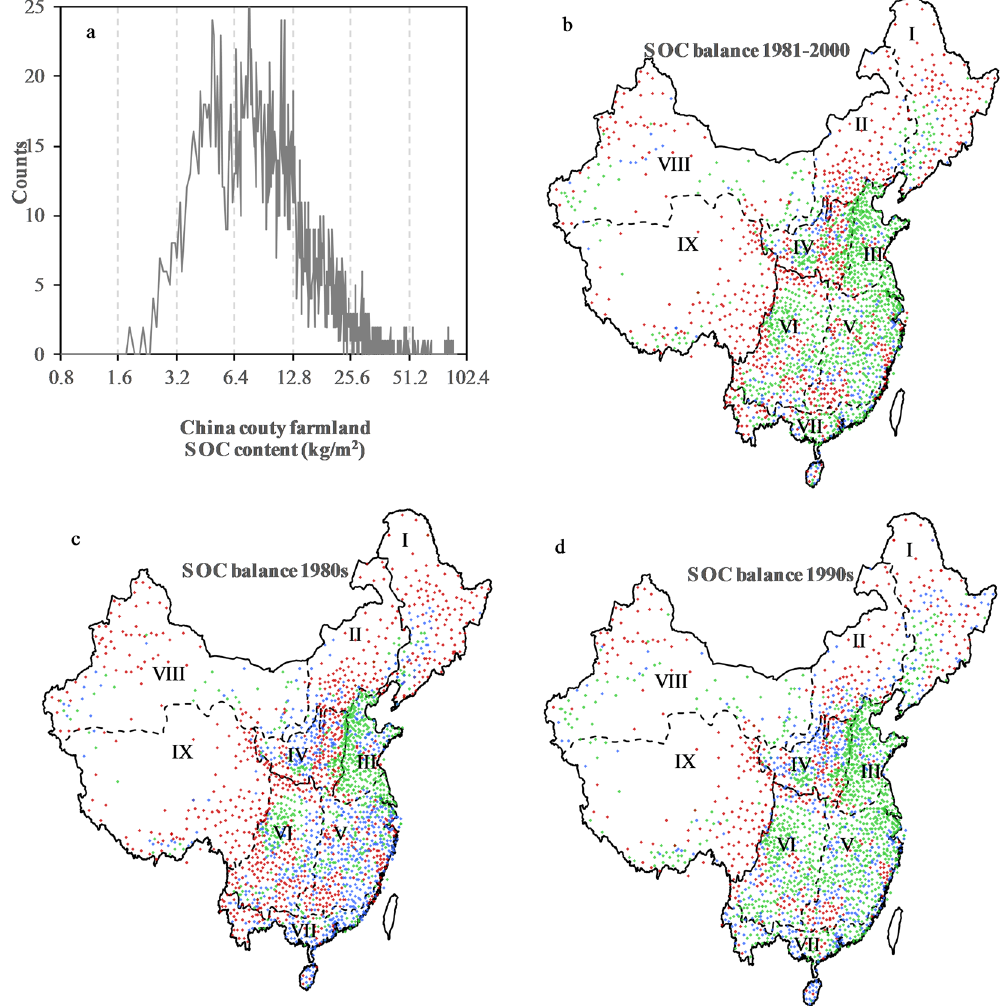
Figure 3. ( a ) SOC content of cropland in China. ( b ) SOC balance of cropland in China from 1981 to 2000. ( c ) SOC balance of cropland in the 1980s. ( d ) SOC balance of cropland in the 1990s. Green represents C sinks. Blue represents C-neutral areas. Red represents C sources. The figure was generated using Microsoft excel 2016 software provided by Microsoft